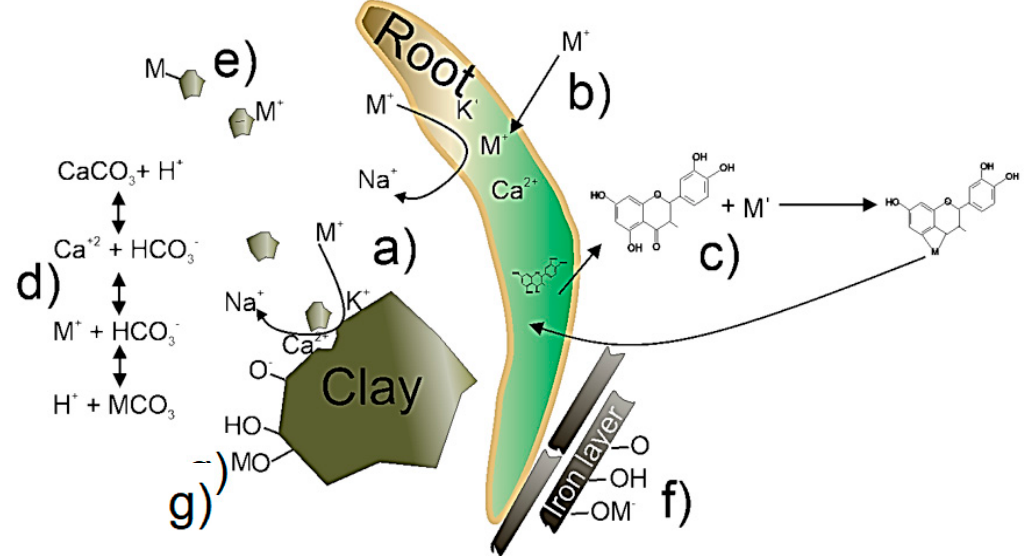
Figure 2. Metal removal mechanisms in constructed wetlands by plant and support material. ( a ) cation exchange; ( b ) plant uptake; ( c ) metal chelation by root exudates; ( d ) carbonate precipitation; ( e ) adsorption to particulate matter; ( f ) adsorption onto iron layer and ( g ) adsorption onto clay material.